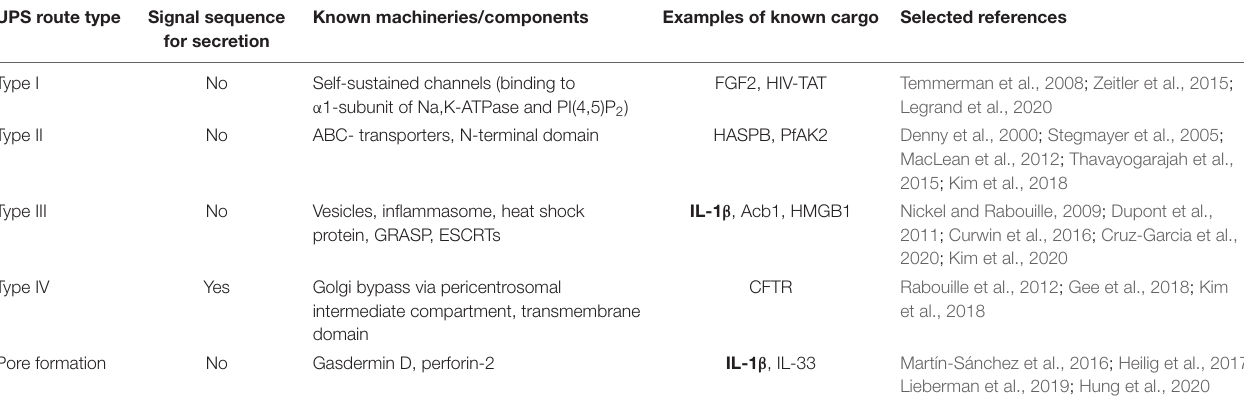
TABLE 1 | Overview of UPS pathways including information on known machineries or components and relevant cargo examples. UPS route